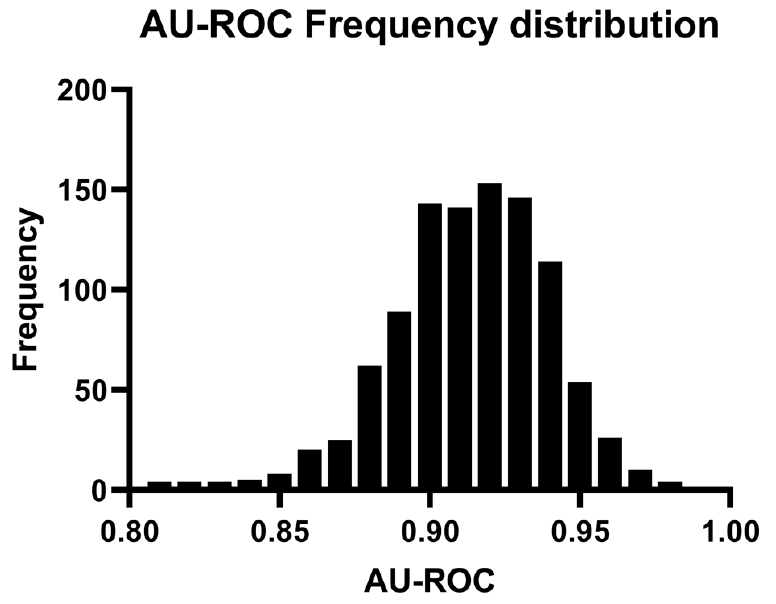
Figure 3. AU-ROC distribution for validation cohort during a 1000-time repeated random sub-sampling validation (median: 0.92, min: 0.81, max: 0.98). For each resampling, a discovery cohort (randomly selected 70% of all samples, with PCa cases: n = 102/controls: n = 190) was used to establish an OPLS-DA model, the model was then validated by predicting samples in the corresponding validation cohort (remainder of all samples, with PCa cases: n = 44/controls: n = 82), and an AU-ROC for each prediction was calculated. AU-ROC, Area under the receiver operating characteristic